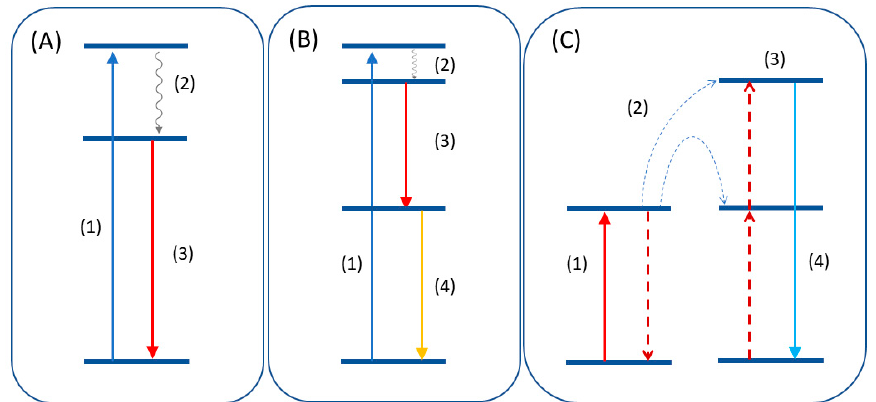
Figure 2. ( A ) Downshift mechanism consisting of excitation (1), non-radiative decay (2), and emission (3). ( B ) Quantum cutting mechanism where the emission of two photons (3,4) occurs after the excitation. ( C ) Upconversion emission after energy transfer (2) of two lower energy quanta to a higher excited state